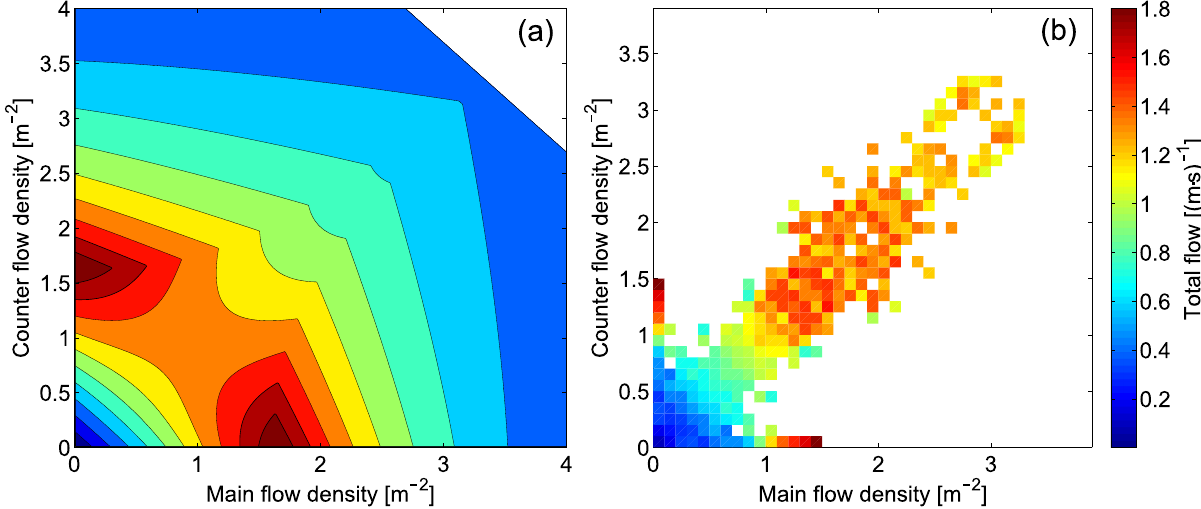
Fig 17. Bidirectional flow fundamental diagram. Comparison between experimentally obtained data and the particular FD by Flo¨ttero¨d and La¨mmel. The whole database is used to create the experimental fundamental diagram.